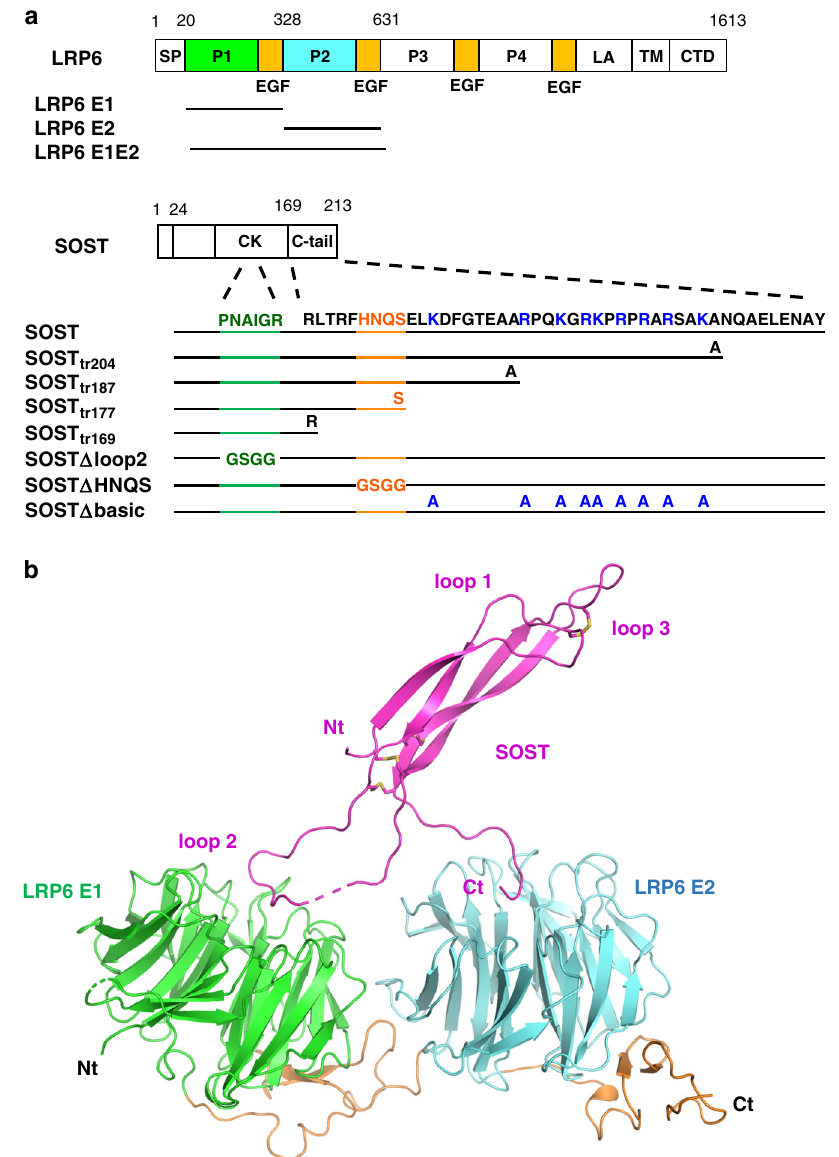
Fig. 1 Construct design and the crystal structure of the LRP6 E1E2 – SOST tr177 complex. a Schematic representations of the LRP6 and SOST constructs. SP signal peptide, P β -propeller domain, EGF epidermal growth factor-like domain, LA LDLR type-A repeats, TM transmembrane domain, CTD C-terminal domain, CK cystine-knot domain. The amino acid residues interacting with LRP6 E1 in the SOST-loop 2 region are shown in dark green. The SOST C- terminal tail sequences including HNQS (orange) and the basic-residue clusters (blue) are also shown. Construct information is described in detail in Supplementary Table 1. b The crystal structure of the LRP6 E1E2 – SOST tr177 complex is represented with a ribbon diagram. For simplicity, only one complex out of two in an asymmetric unit is shown (Supplementary Fig. 4). SOST is colored in magenta, and disul fi de bonds are represented as yellow sticks. SOST residues 122 – 127 are not resolved in this structure and are represented as a dashed line. The LRP6 E1 β -propeller domain is colored in green, and the E2 β - propeller is shown in cyan. The EGF domains are shown in